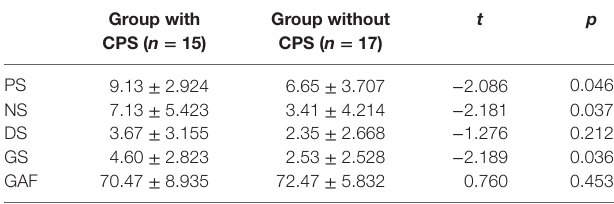
TaBle 4 | Severity of attenuated psychotic symptoms and GAF in two groups ( x ± SD). group with cPs ( n = 15)